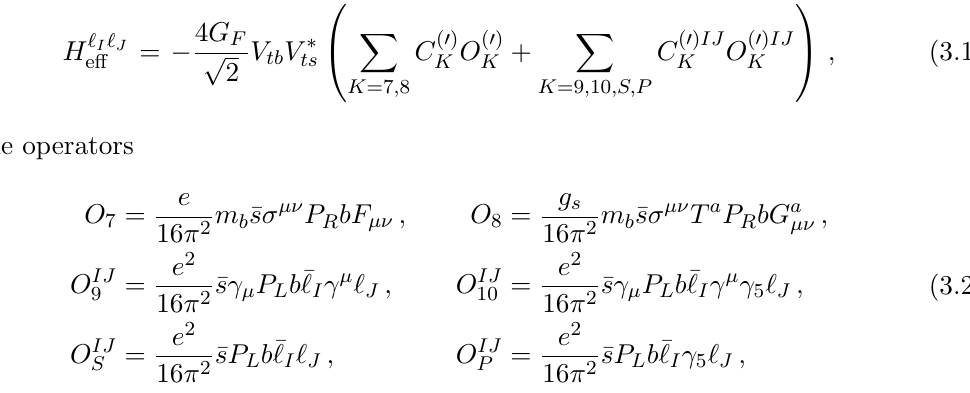
Table 1 . Relations between the parameters " F one of the other four bases with " F 2HDMs with natural (cid:13)avour conservation and induce (cid:13)avour changing neutral